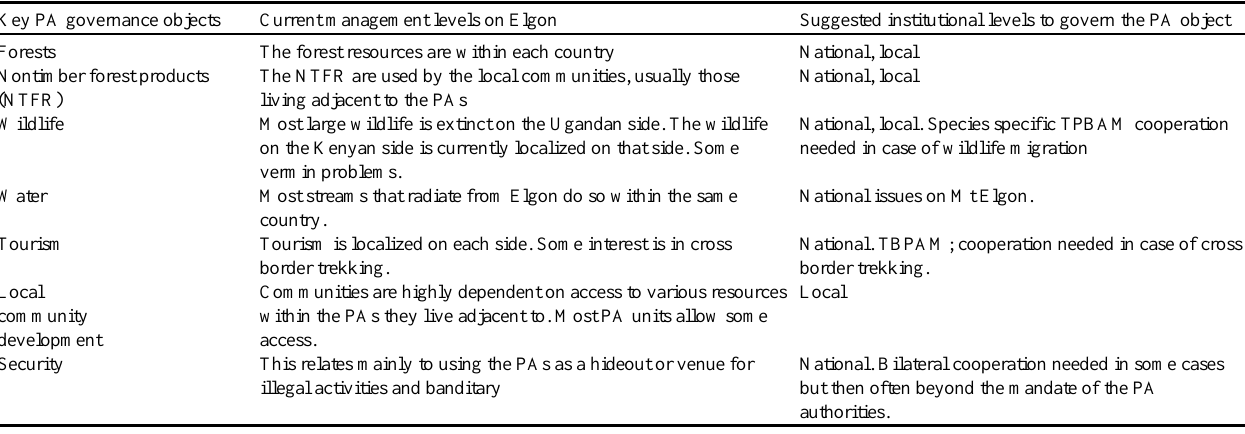
Table 4 . Suggested institutional levels for management of some key governance objects in the protected areas (PA) on Mt Elgon. TBPAM = transboundary protected area